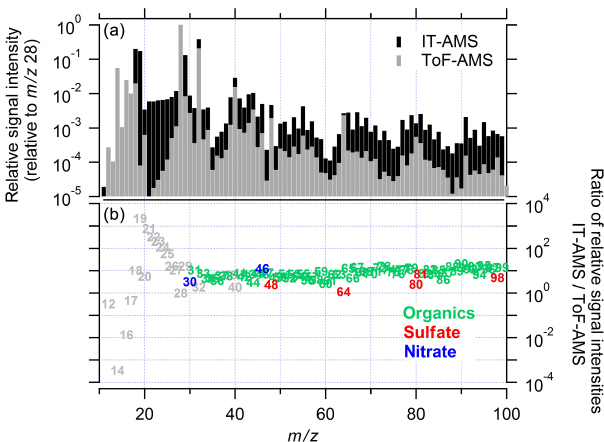
Figure 2. Comparison of average difference mass spectra measured with the IT-AMS and the ToF-AMS during 11-day-long ambient measurements. Shown are the average mass spectra normalised (af- ter conversion to ion rates) to their respective mass spectral signal at m/z 28 (a) and the ratio (IT-AMS to ToF-AMS) of these relative signal intensities, colour-coded for the dominant species at the re- spective m/z (b) . Note the logarithmic scaling of the y axes and that the upper panel’s y axis only starts at 10 − 5 (i.e. ion signals smaller than that are not